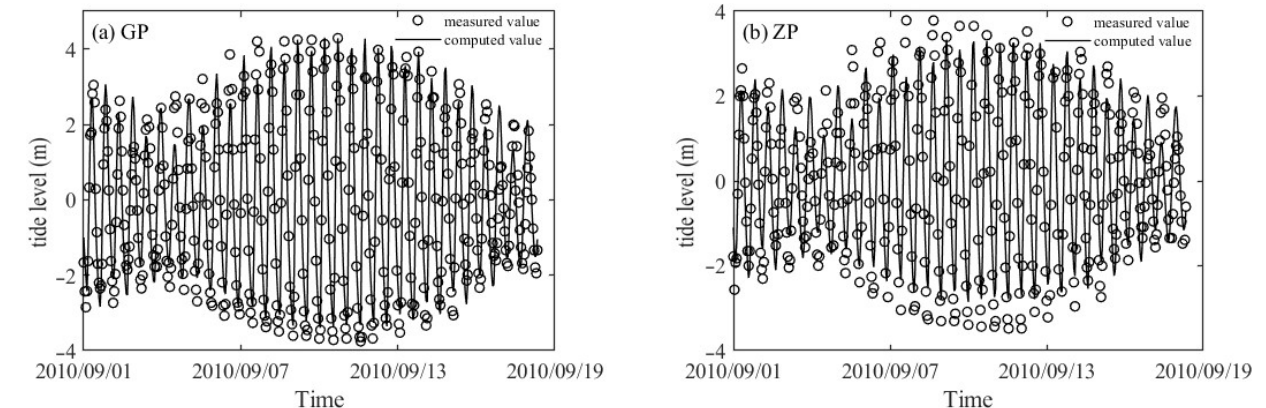
Figure 2. Time series of the hourly tide level records along Hangzhou Bay at the GP ( a ) and ZP ( b ) stations during September 2010.